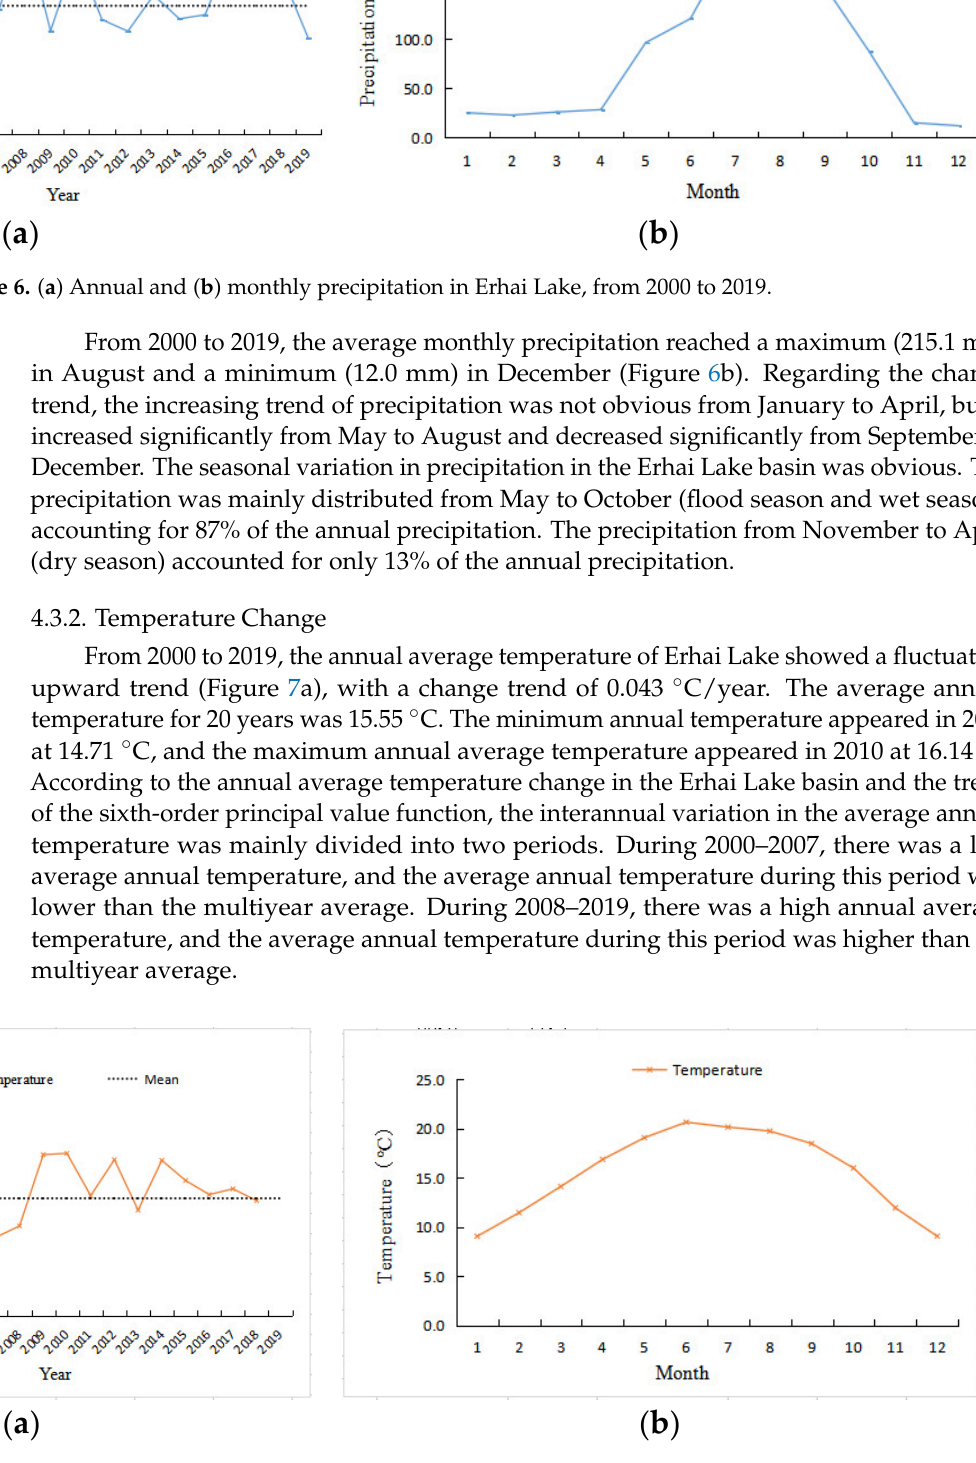
7 of 16 Figure 5. TN concentration of Erhai Lake and its sections in the north-south direction from 2002 to 2019. 4.3. Influence of Precipitation and Temperature on Water Environment 4.3.1. Precipitation Change From 2000 to 2019, the average annual precipitation of Erhai Lake presented a fluc- tuating upward trend (Figure 6a), with a change trend of 2.939 mm/year, and the average annual precipitation over 20 years was 949.54 mm, with a minimum annual precipitation of 613.2 mm in 2006 and a maximum annual precipitation of 1282.2 mm in 2008. According to the change in annual precipitation and the trend of the sixth-order principal value func- tion in the Erhai basin, the interannual variation in precipitation could be divided into five periods. Specifically, 2000–2002, 2008–2012, and 2016–2019 were periods with more pre-